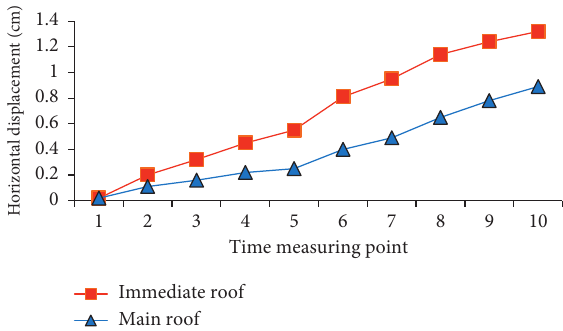
Figure 20: Horizontal displacement of roof strata.